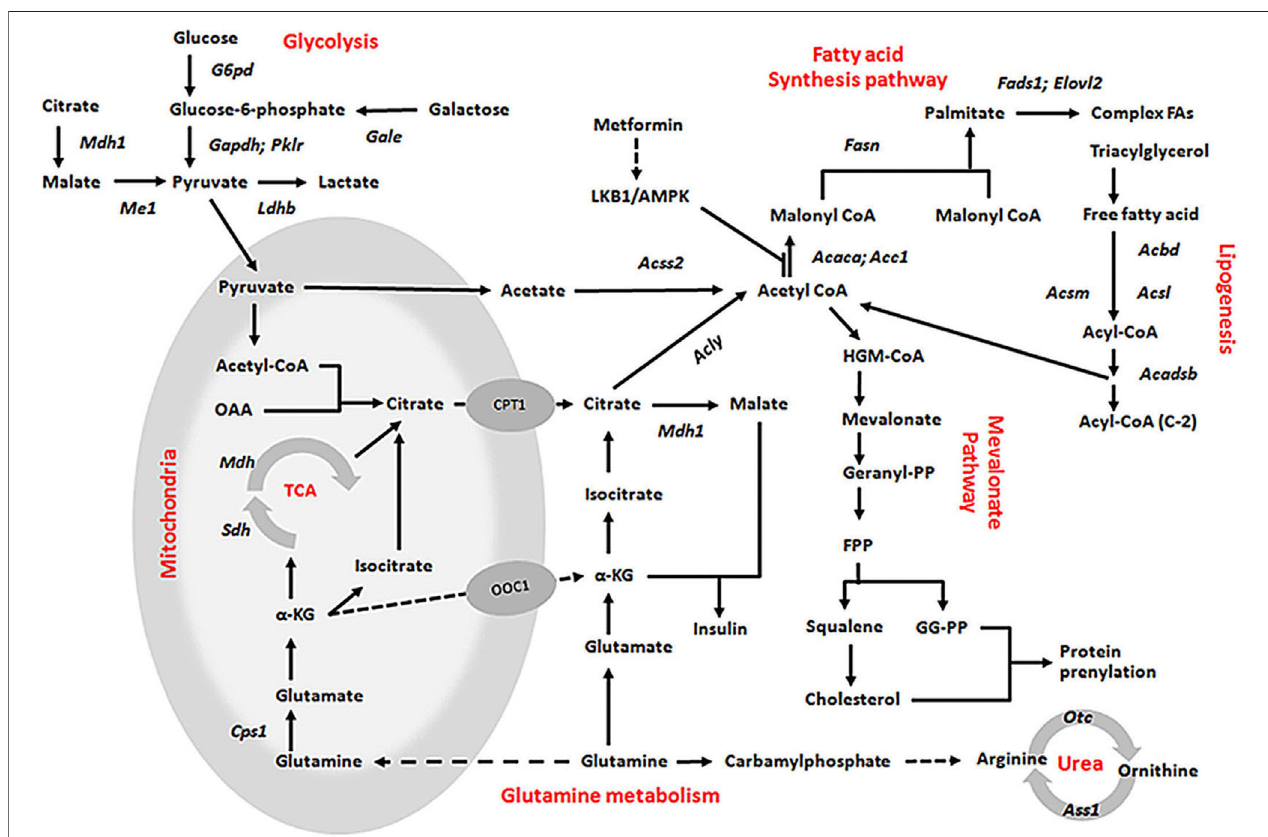
FIGURE 5 | Proposed mechanisms for the role of KLF10 in the lipogenesis, glycolysis, and glutamine metabolism pathways. All indicated genes with italic words were upregulated by KLF10, which presented a signi fi cant fi vefold change in the expression array.